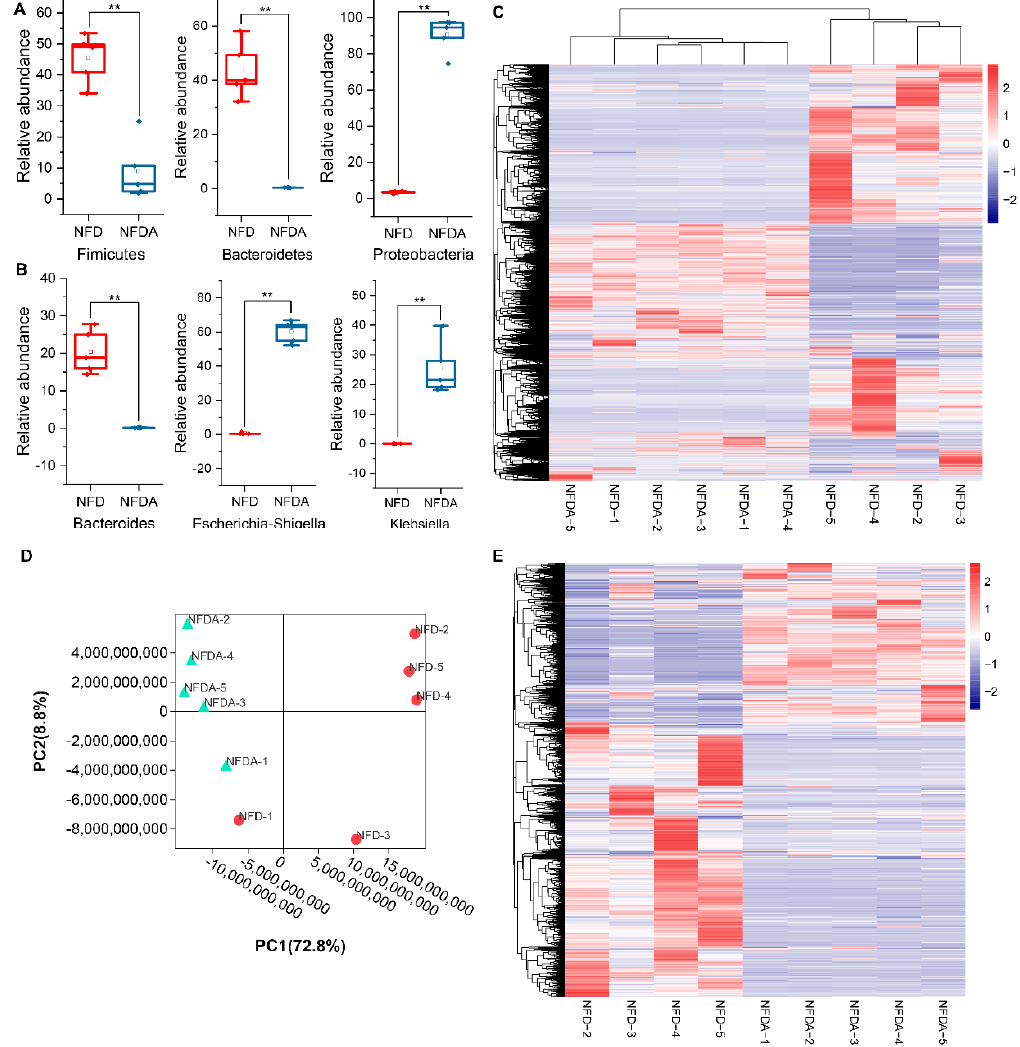
Figure 2. The effect of antibiotic treatment on cecal microbiota and metabolomics. ( A ) The impact of antibiotic treatment on cecal microbiota at the phylum level. The abundances of Firmicutes and Bacteroidetes were highly significantly depleted by antibiotic treatment, while the abundance of Proteobacteria was highly significantly increased ( p < 0.01). ( B ) The impact of antibiotic treatment on cecal microbiota at the genus level. The antibiotic treatment presented a highly significantly decreased abundance of Bacteroides genus and an increased abundance of Escherichia-Shigella and Klebsiella genera ( p < 0.01). ( C ) Clustering heatmap of all peaks. The red, white, and blue colours represent the expression level from high to low. ( D ) PCA plot of the samples based on all peaks. NFD ( n = 5), NFDA ( n = 5). ( E ) Clustering heatmap of the identified 2378 metabolites across all samples (NFD ( n = 4), NFDA ( n = 5)). ** p <